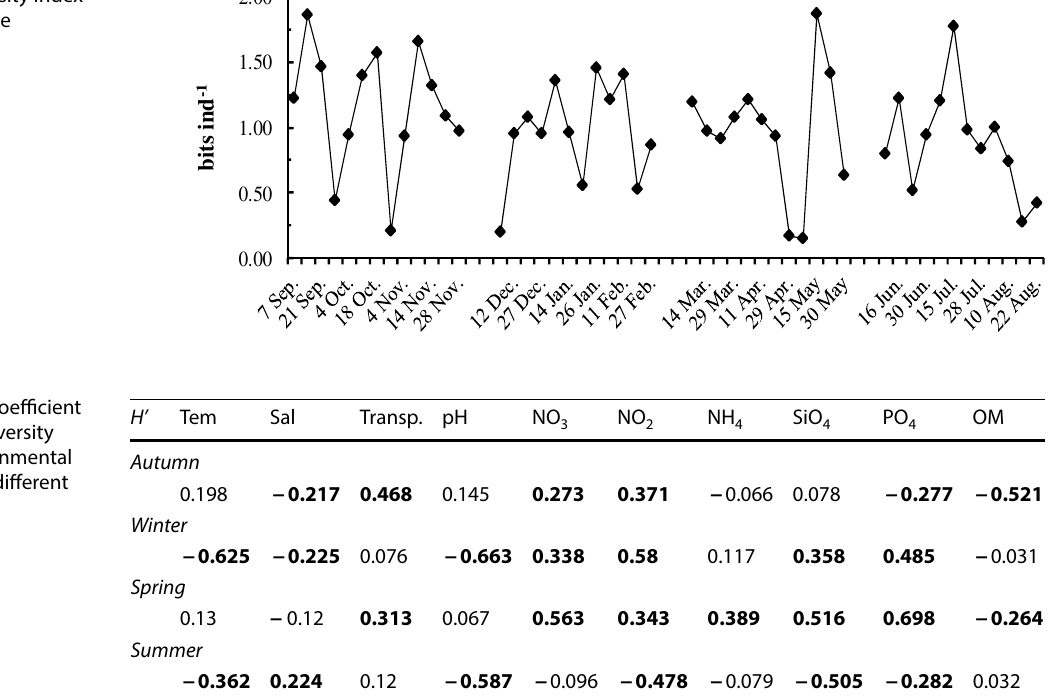
Fig. 3 Shannon diversity Index ( H’ ) during a year cycle